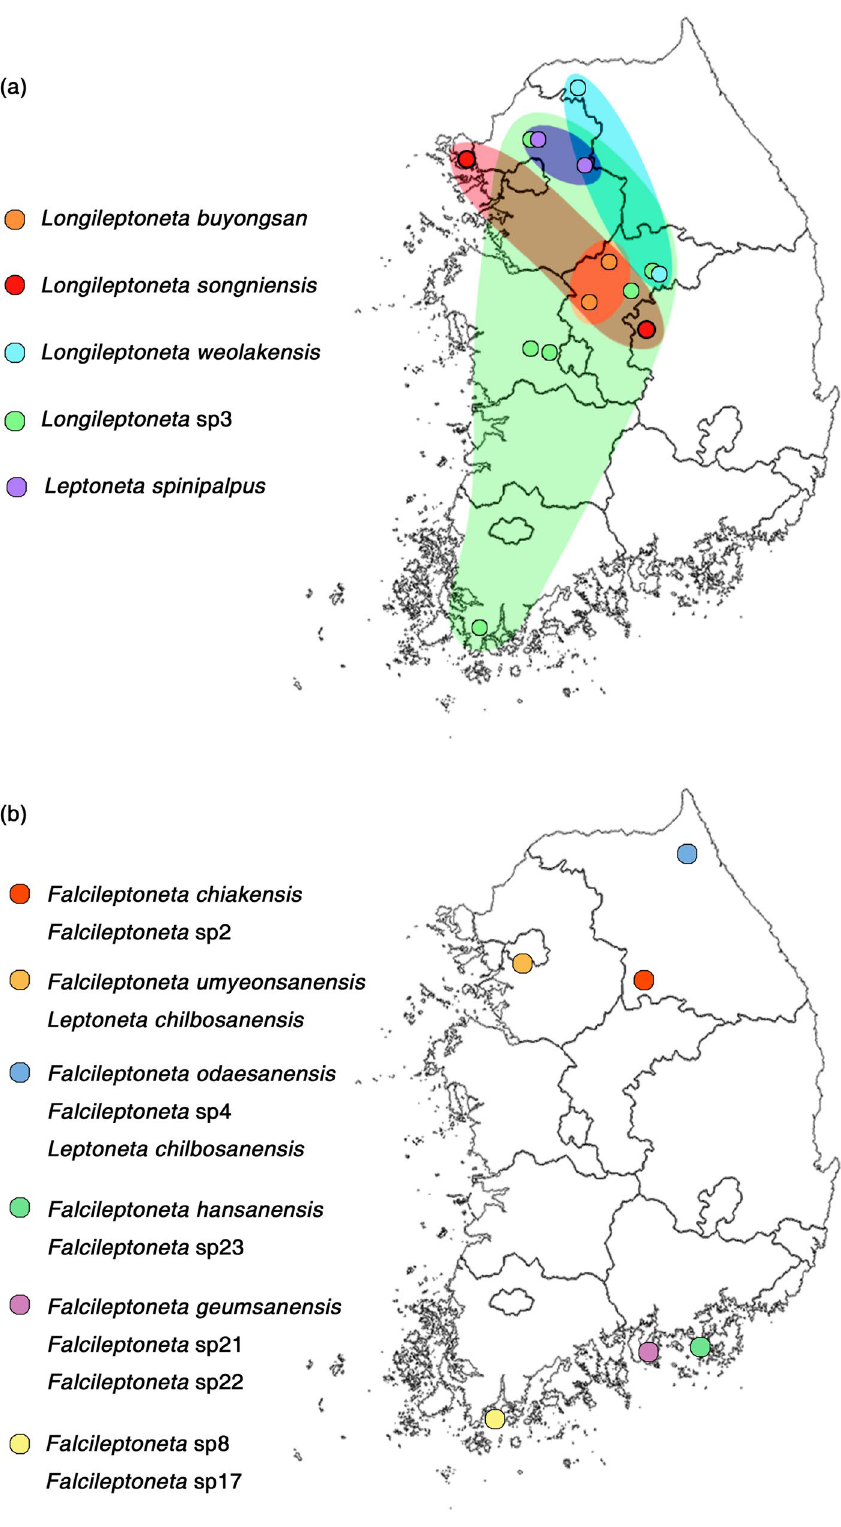
Figure 8. Maps showing sympatric localities between congeneric species. The maps were prepared using QGIS 3.22.1 (https:// www. qgis. org/ ko/ site/). Members of Longileptoneta are mainly wider distributed compared to species of Falcileptoneta , suggesting a possibility that this genus may have potentially more sympatric